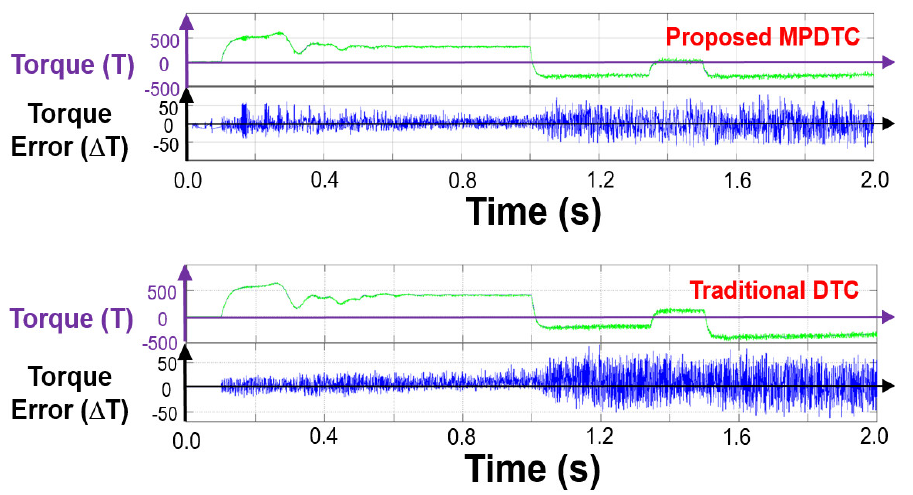
Figure 14. Simulated torque errors of the proposed MPDTC and traditional DTC systems between 0 and 2 s.